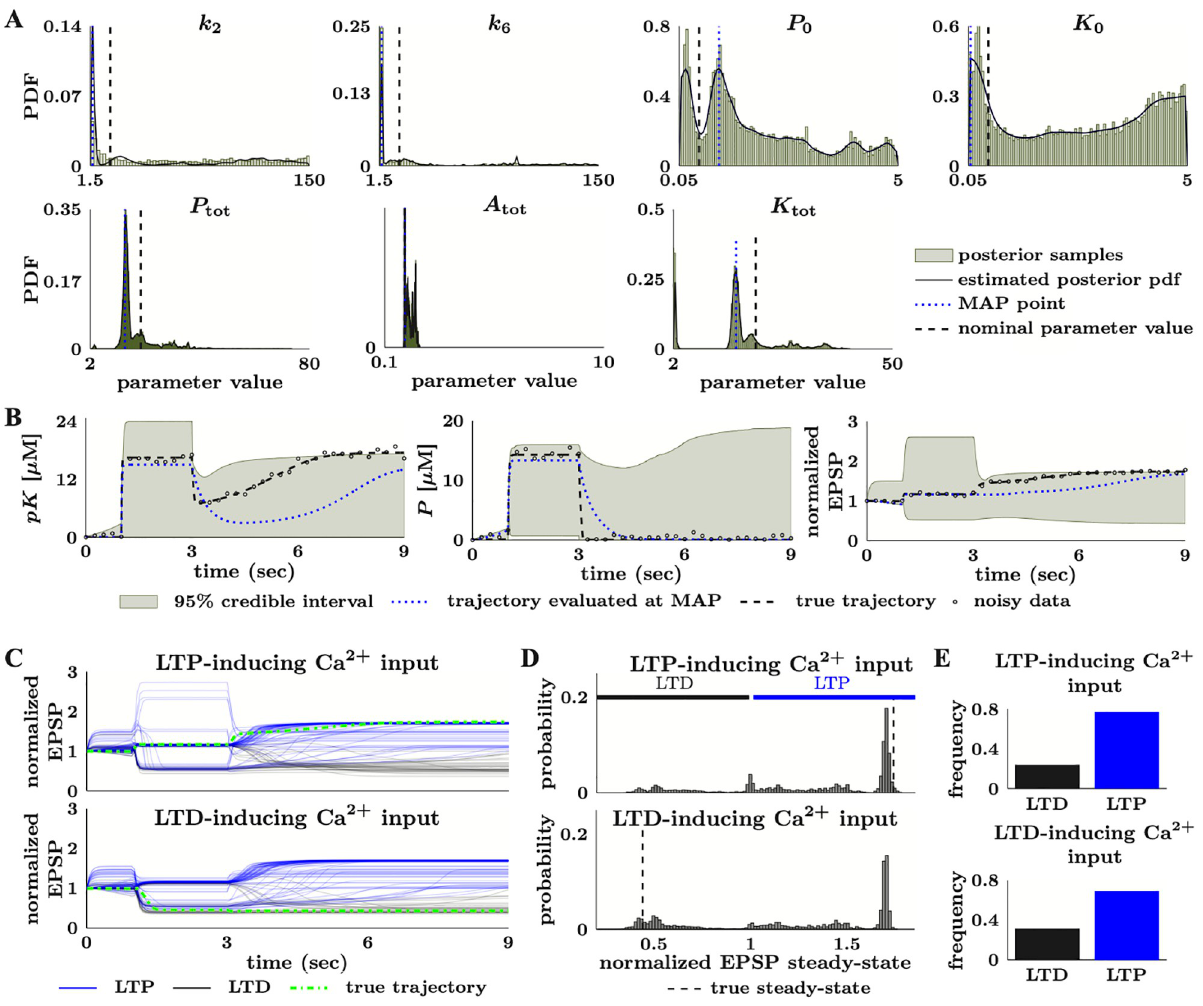
Fig 9. Comprehensive parameter estimation and uncertainty quantification reveal failures to predict the correct long-term model behavior. ( A ) We estimated marginal posterior distributions of the model parameters from noisy data with an LTP-inducing calcium input. Distributions are visualized by fitting a kernel density estimator to 547,500 (150 walkers with 3,649 steps each) MCMC samples obtained using CIUKF-MCMC with AIES for MCMC after discarding the first 4,351 samples per walker as burn-in. ( B ) Posterior distribution of the trajectories of the state variables show LTP (normalized EPSP > 1) and LTD (normalized EPSP < 1) responses for an LTP inducing input. The true trajectory (dashed black line) shows the dynamics with the nominal parameters, the dotted blue line shows the trajectory evaluated at the MAP point, and the points show the noisy data (covariance is 1% of the variance of the true trajectory). The 95% credible interval shows the region between the 2.5th and 97.5th percentiles that contains 95% of 30,000 posterior trajectories. ( C ) Sample posterior trajectories (100 out of 30,000 total) highlight the LTP (blue lines) and LTD (black lines) in response to the LTP inducing input (top) and the LTD inducing input (bottom). The dashed green lines show the true trajectories for the respective calcium inputs. ( D ) Histograms reveal the distribution of the long-term responses to the LTP-inducing input (top) and the LTD-inducing input (bottom). The dashed black lines show the true response for the respective calcium inputs. ( E ) Quantifying the percentage of the 30,000 sample trajectories that produce LTD and LTP responses for each calcium input. The LTP-inducing input yields 76.59% (22,972 samples) of the responses in the LTP state and 23.41% (7,024 samples) in the LTD state. The LTD inducing input yields 68.93% (20,680 samples) of the responses in the LTP state and 31.07% (9,320 samples) in the LTD